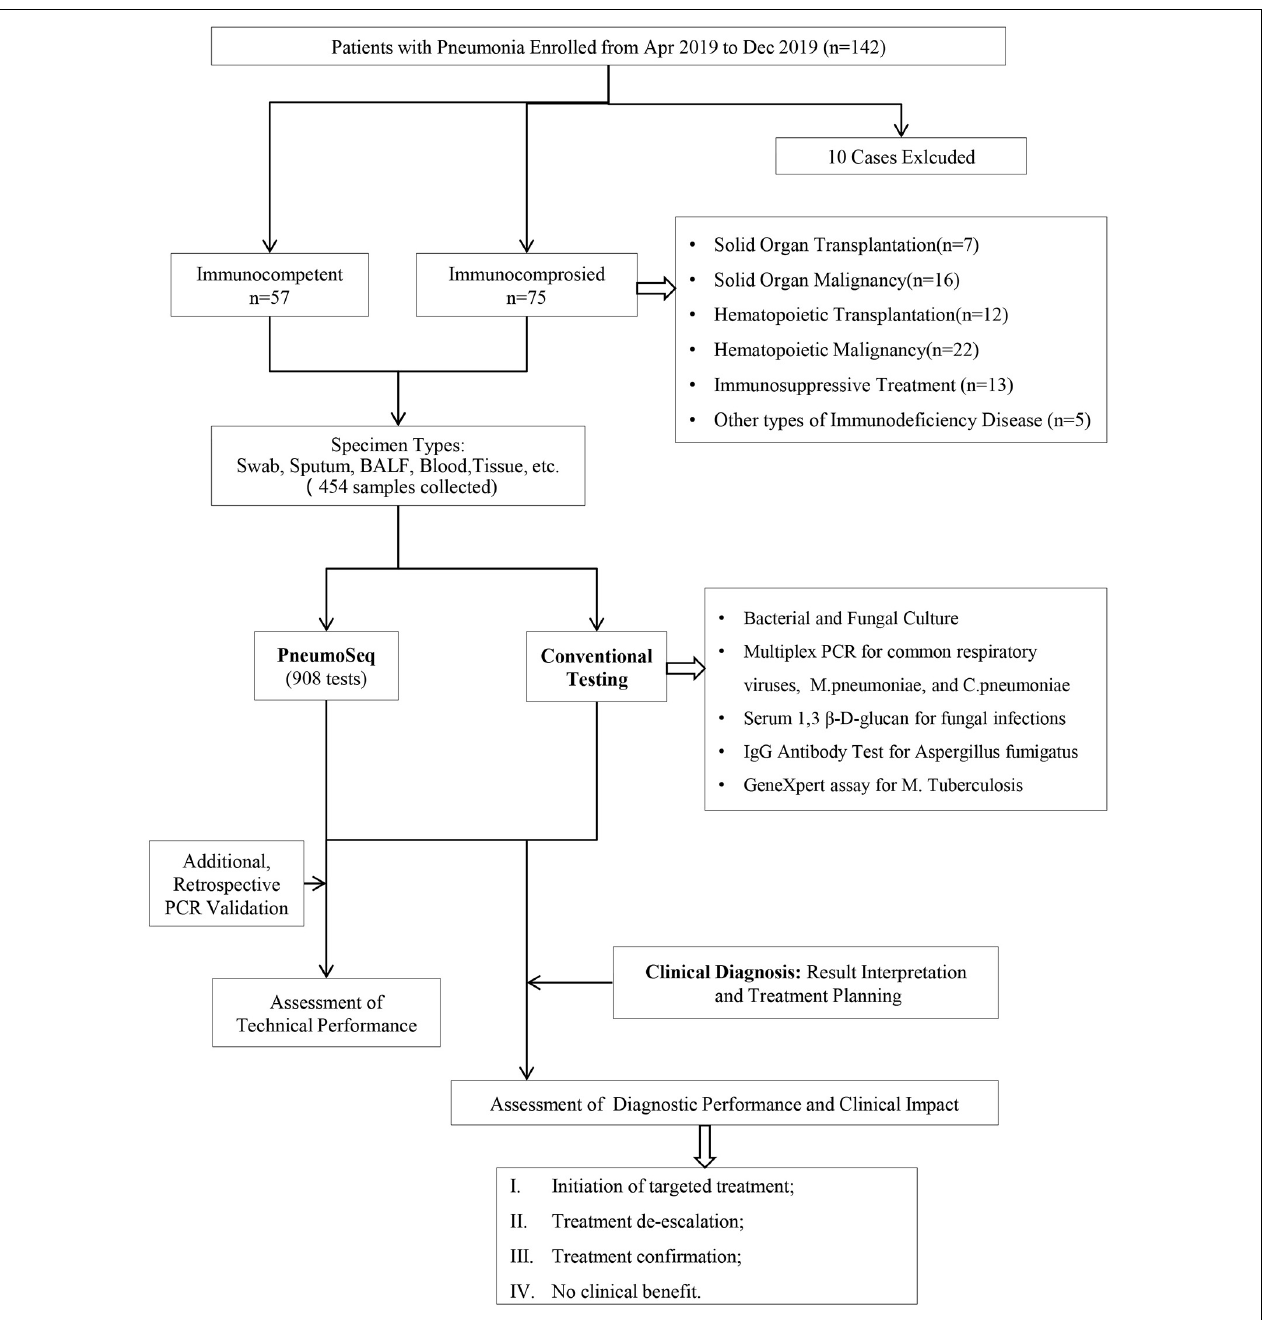
FIGURE 1 | Overview of the study design. A total of 132 patients and 454 clinical specimens were tested. The performance and clinical value of PneumoSeq were evaluated based on comparisons with conventional testing and clinical diagnosis results and its impact on clinical management. BALF, bronchoalveolar lavage fluid; PCR, polymerase chain